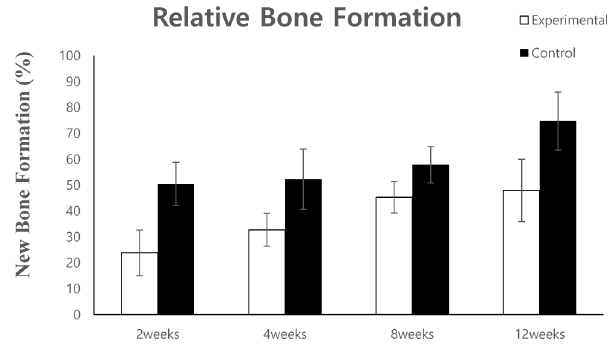
Figure 7. Histomorphometric analysis of new bone formation at the bone defect area.